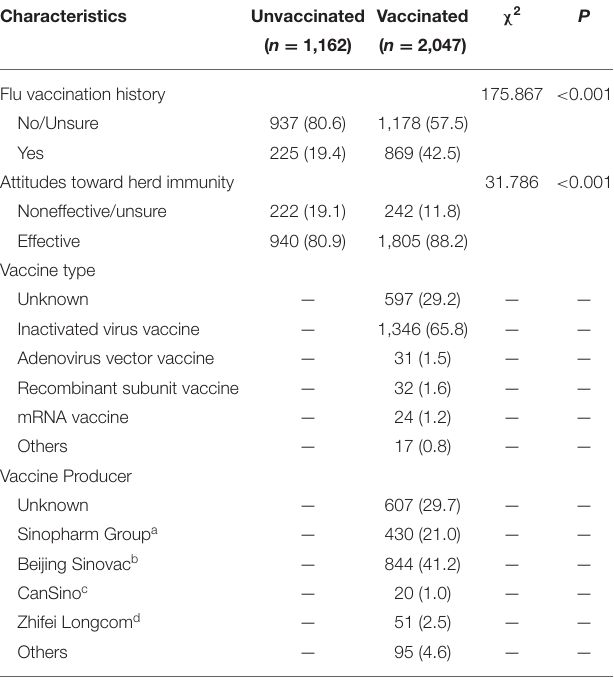
TABLE 2 | The vaccination characteristics of the 3,209 respondents in the survey.